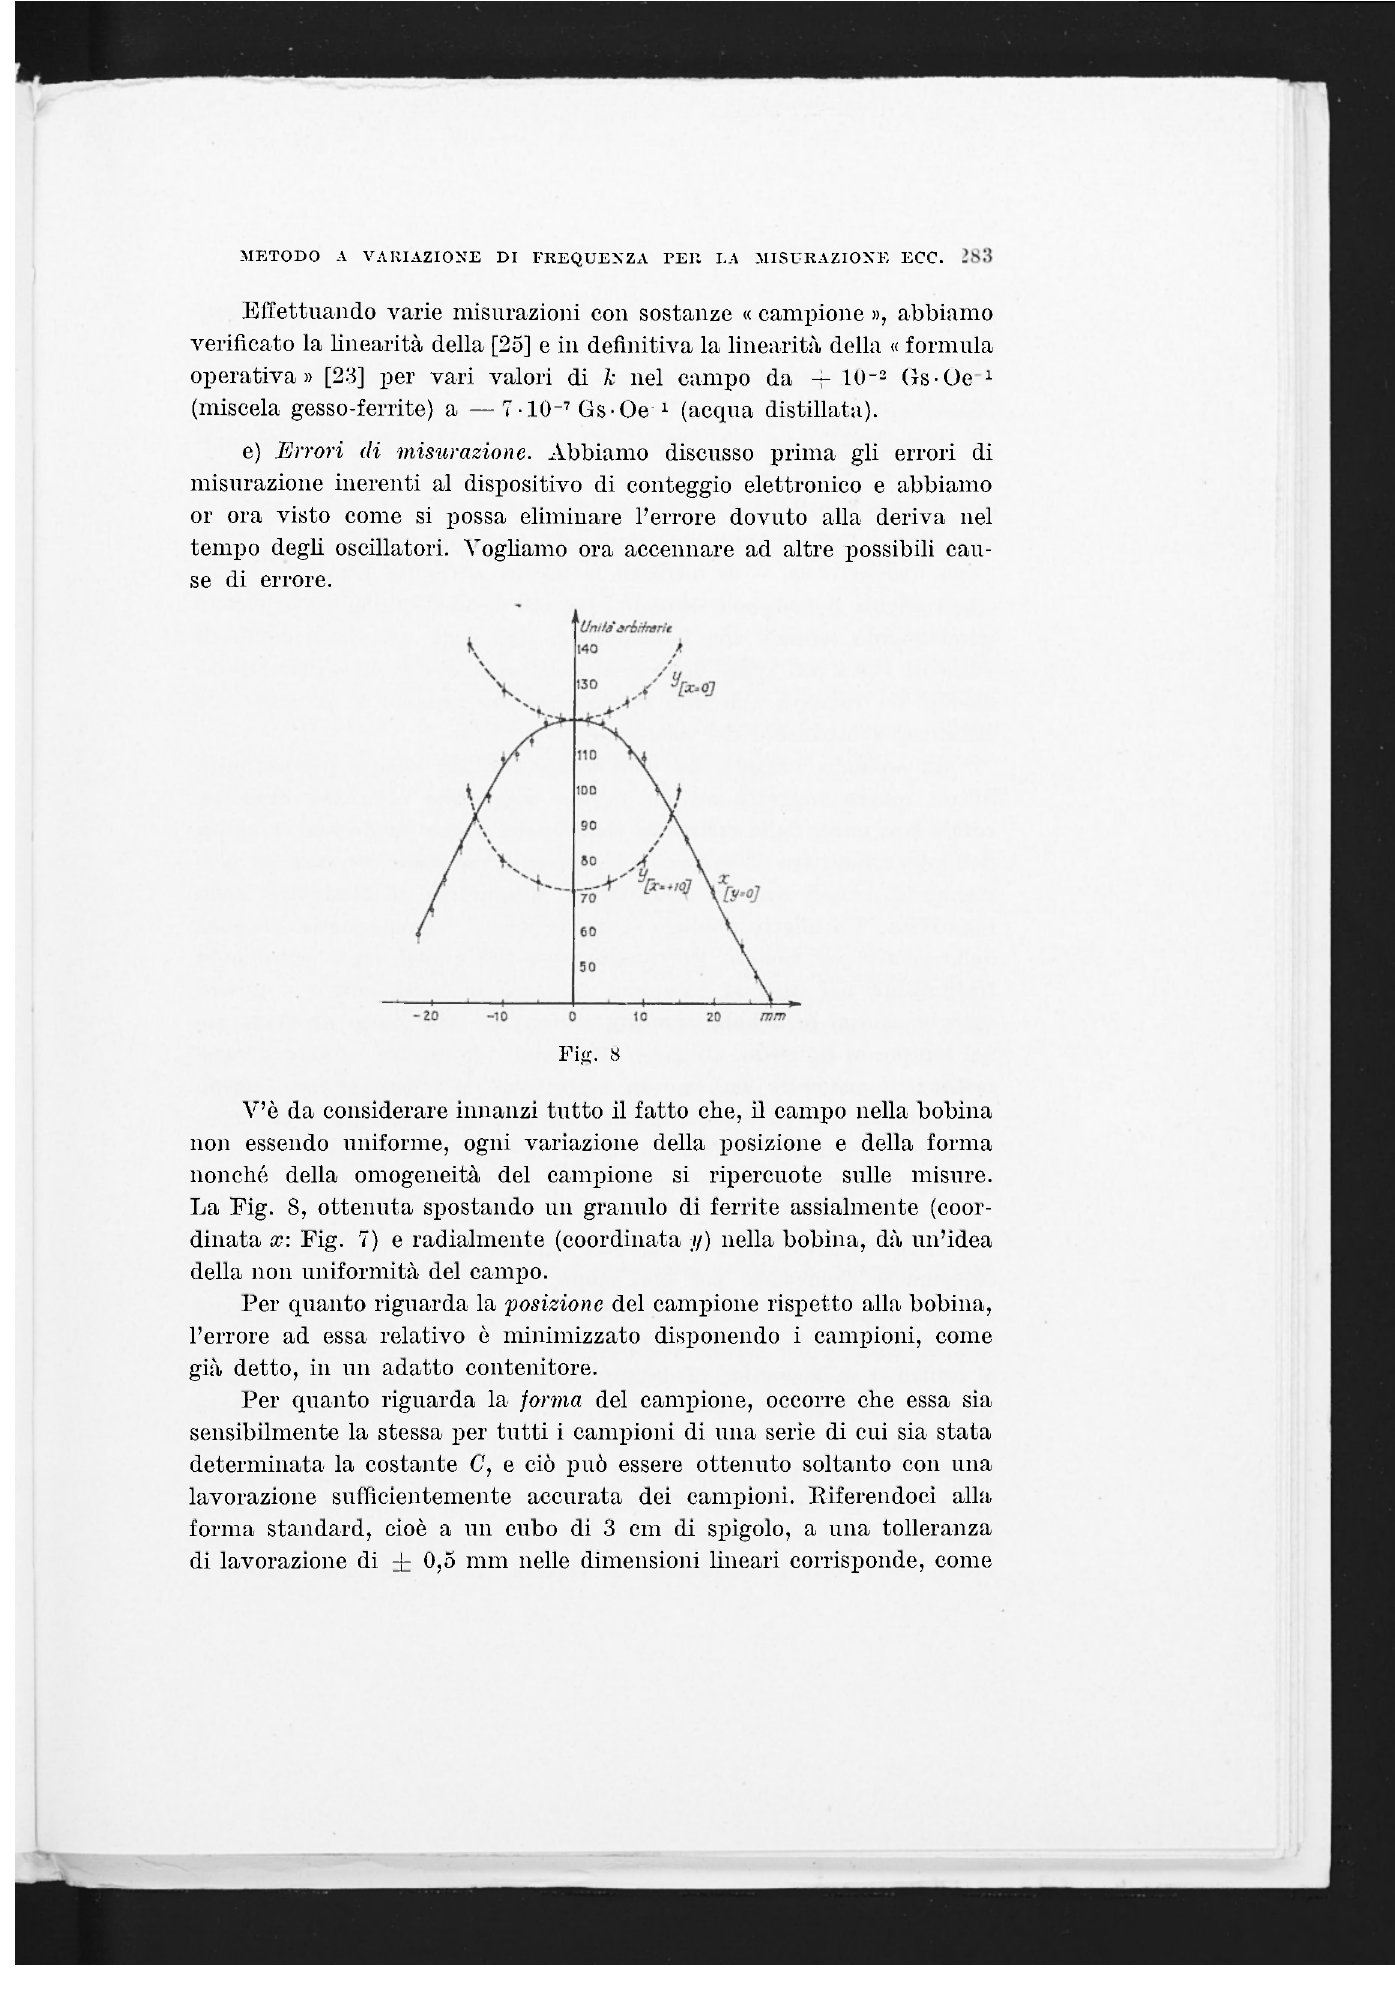
dinata x: Fig. 7) e radialmente (coordinata y) nella bobina, dà un'idea della non uniformità del